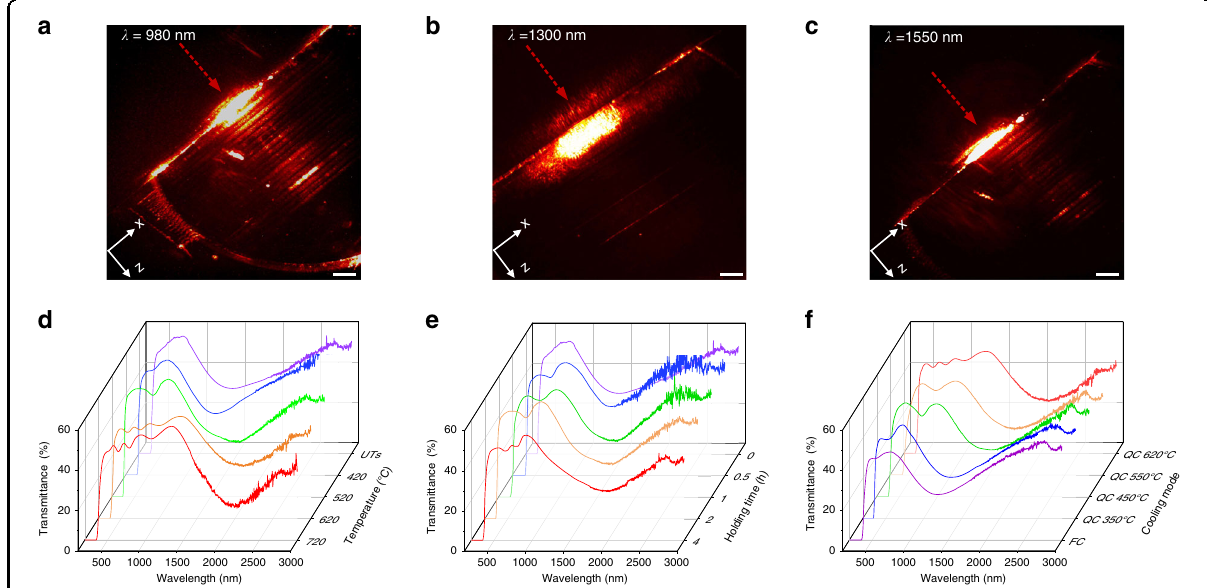
Fig. 4 Optical properties of the textures. a – c Propagation behaviors in multilayer photonic textures of different probe lights with wavelengths of 980 nm ( a ), 1300 nm ( b ), and 1550 nm ( c ), respectively. The red dotted arrows indicate the direction of the incident probe light. Scale bar: 200 µm. d – f Dependence of transmittance spectra of the photonic textures on different holding temperatures with a holding time of 2 h ( d ), different holding times with a holding temperature of 520 °C ( e ), and different cooling modes ( f ). QC and FC indicate quench cooling and furnace cooling, respectively. For example, QC 450 °C means performing quench cooling at 450